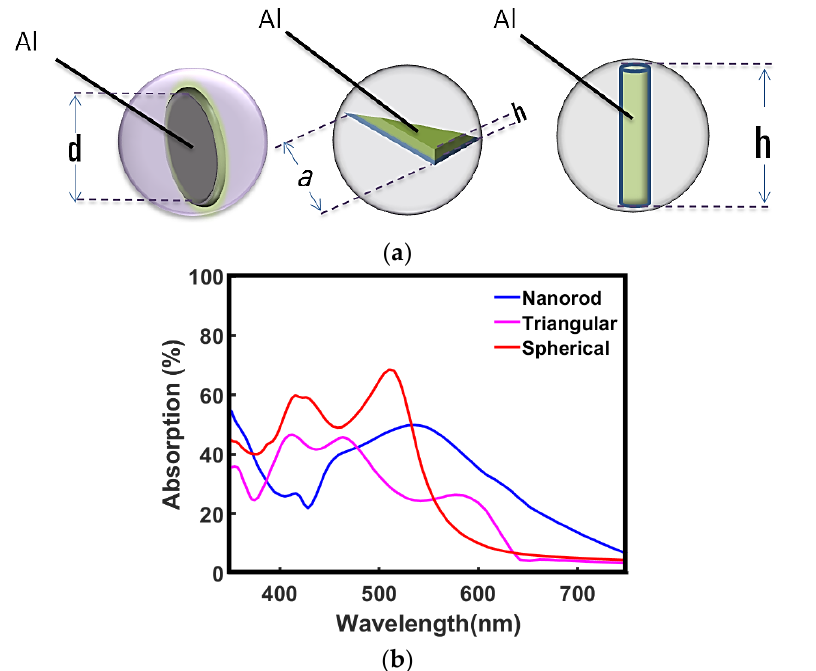
Figure 3. ( a ) Various geometries of aluminum nanoparticles incorporated in SiO 2 ; ( b ) UV-Vis ab- sorption spectrum of photoanodes based on Al@SiO 2 with different shapes of aluminum nanopar- ticles.